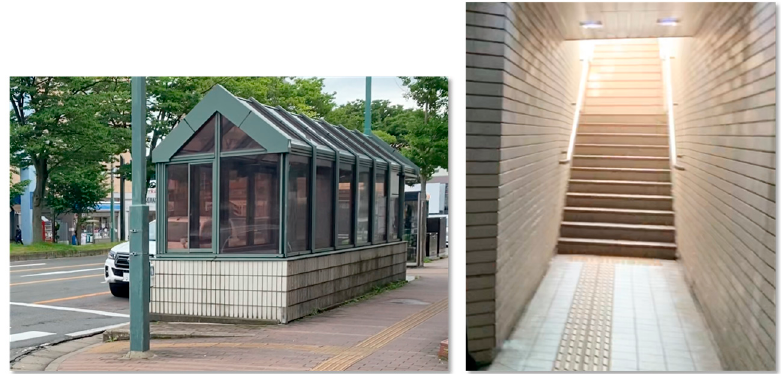
Figure 18. Pedestrian subway.